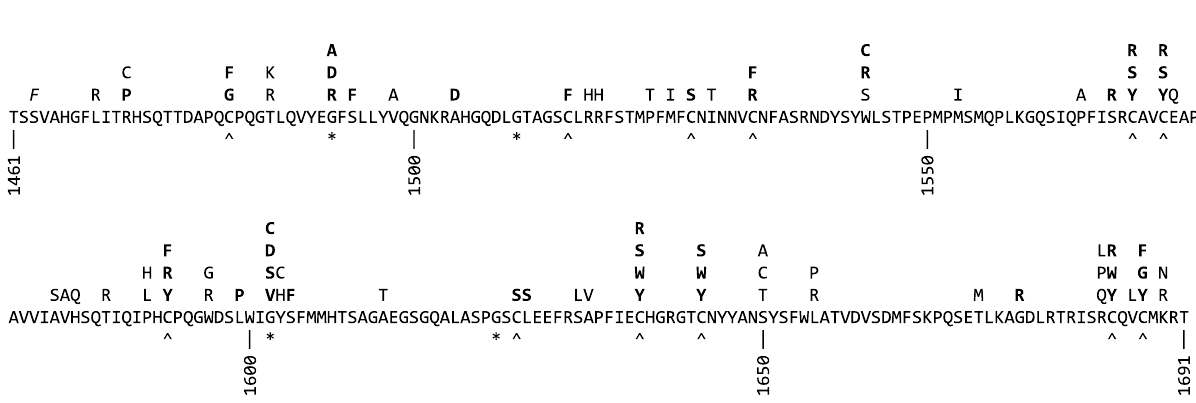
Figure 3. Amino acid sequence of the collagen IV α5 NC1 domain. Substitutions found in LOVD are indicated above the sequence. Substitutions predicted to cause structural damage are in bold, and substitutions where no structural data was available are in italics. Cys residues are indicated with a caret (^), and buried Gly residues with an asterisk